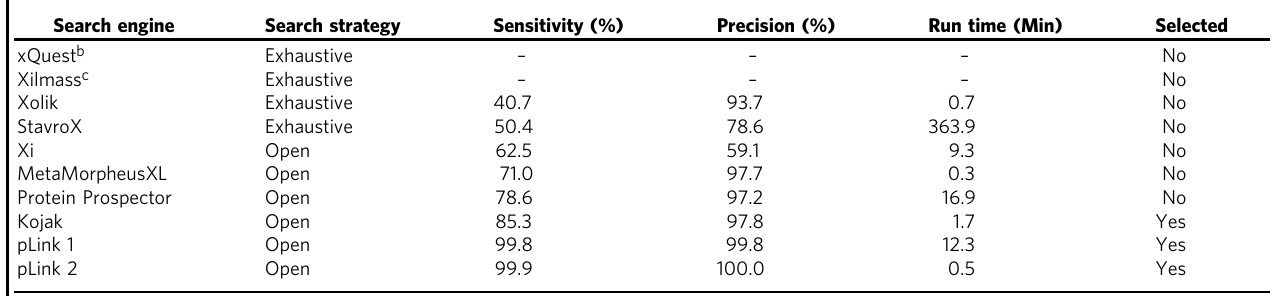
Table 1 The performance of ten search engines on the Simulated-BS3 dataset a